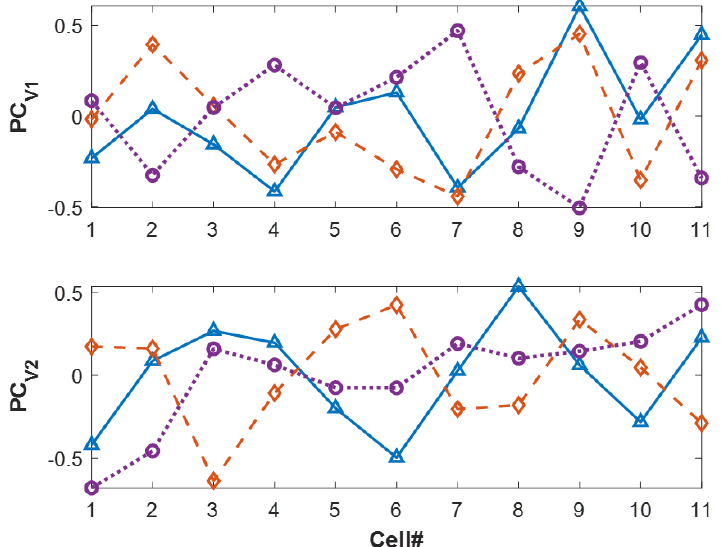
Figure 12. First two voltage principal components before balancing (cid:52) (solid), during balancing (cid:13) (dotted), and after balancing ♦ (dashed).